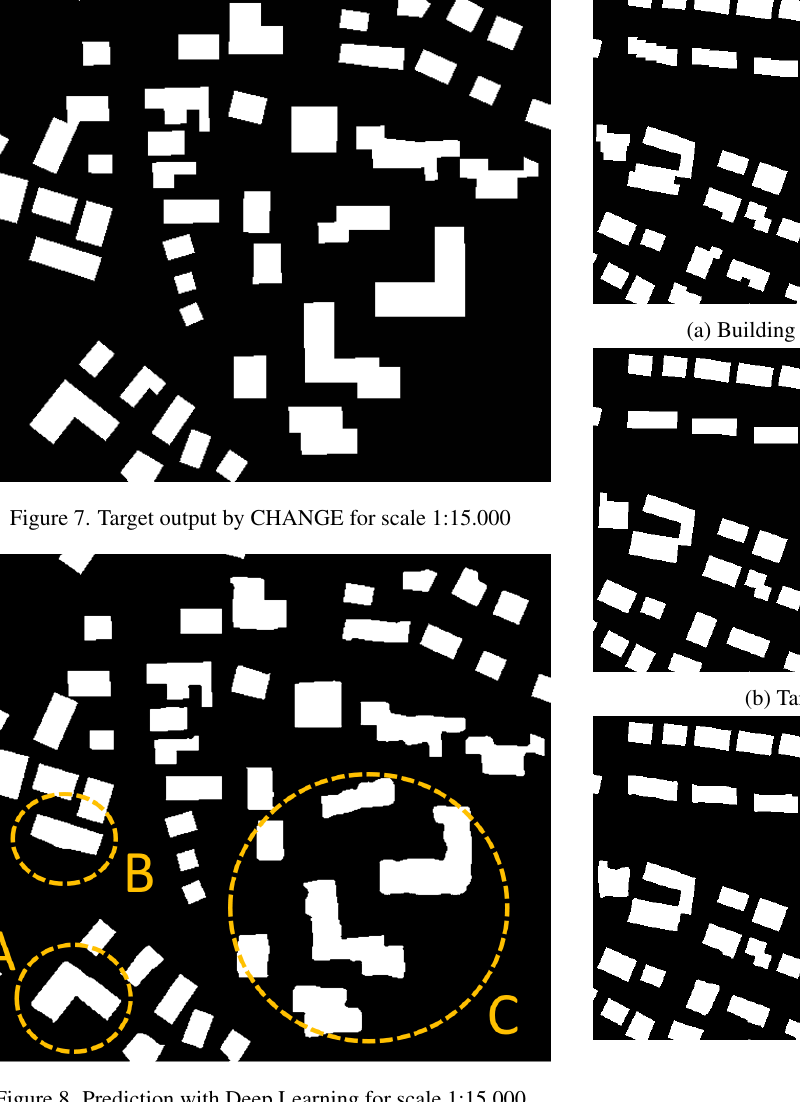
Figure 8. Prediction with Deep Learning for scale 1:15.000